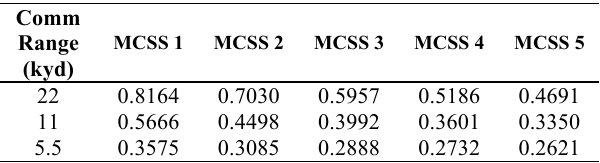
Table 7. Average CPD at 12 Hours of Simulation Time for the